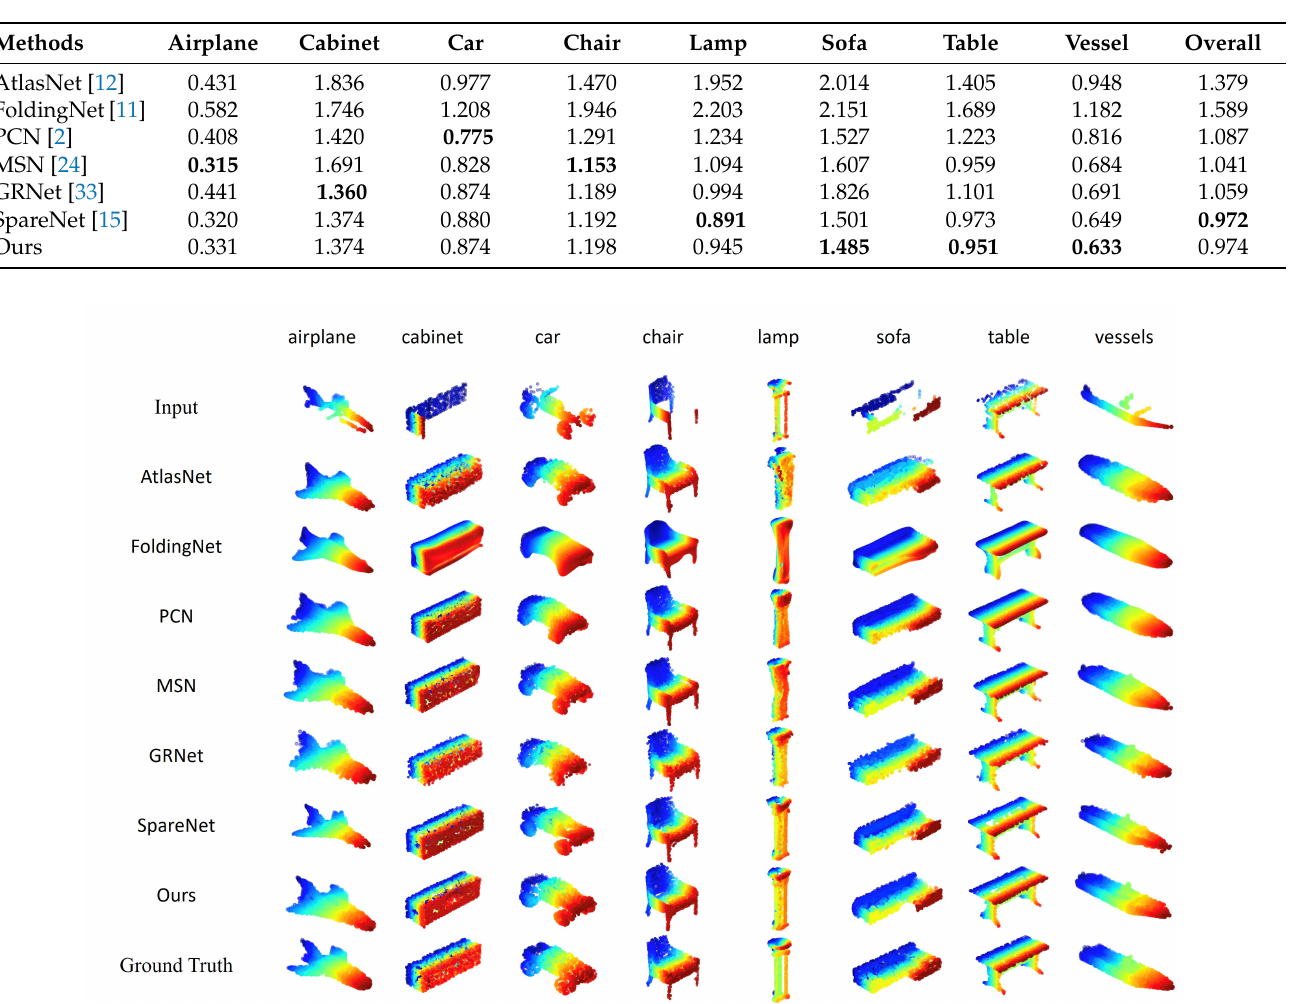
Table 6. Point completion results on PCN in CD × 10 3 (lower is better).